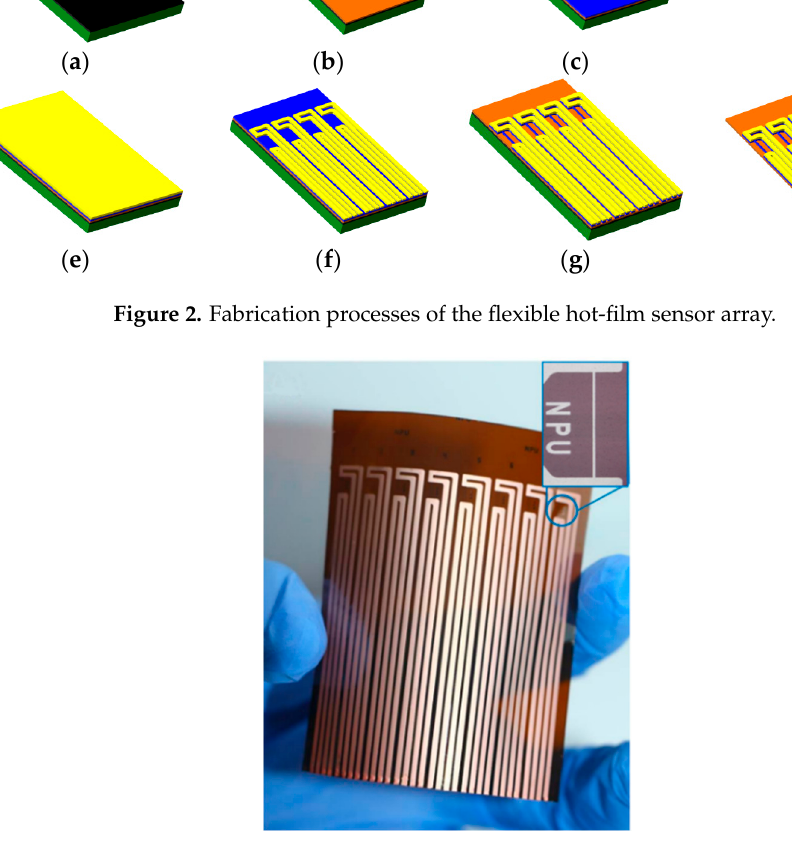
Figure 3. Flexible hot-film sensor array with eight sensors.